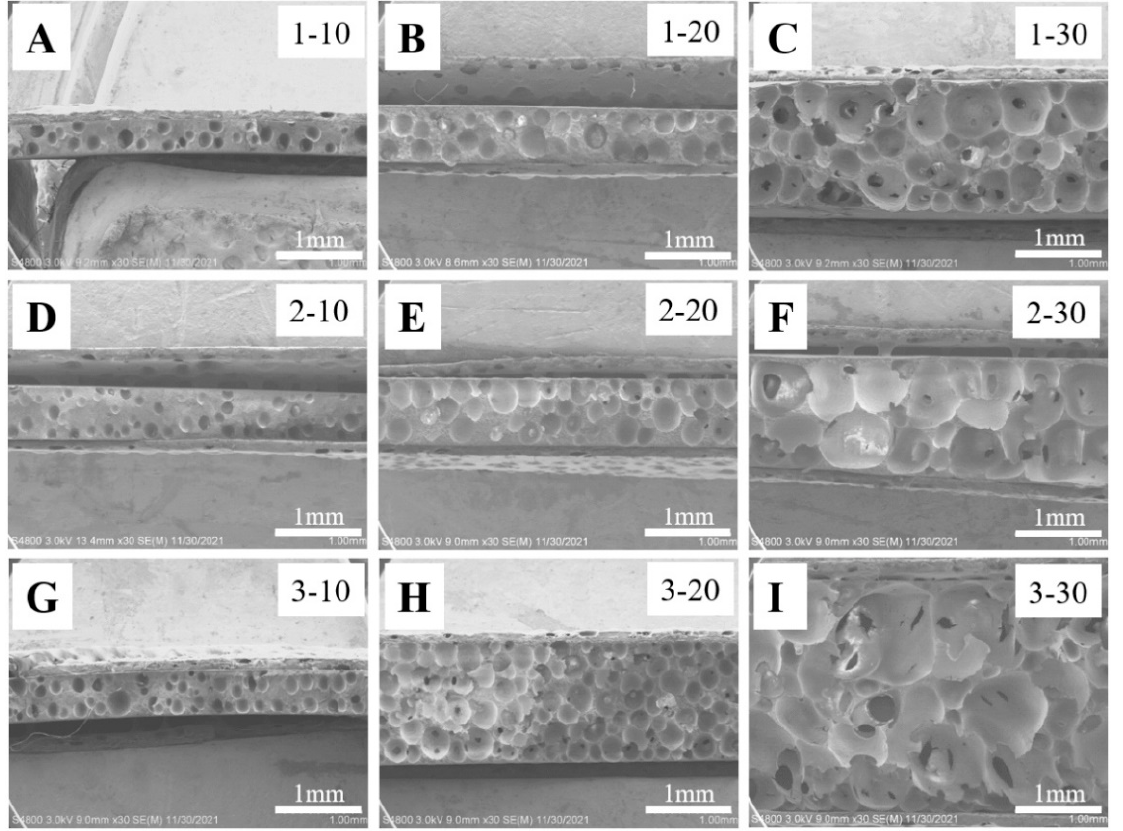
Figure 2. SEM images of the cross–sections of foamed PVDF/PMMA blend films with the indicated ADC content (1% in A to C), (2% in D to F), (3% in G to I) and foaming time (10 min in A, D, G), (20 min in B, E, H), (30 min in C, F, I).